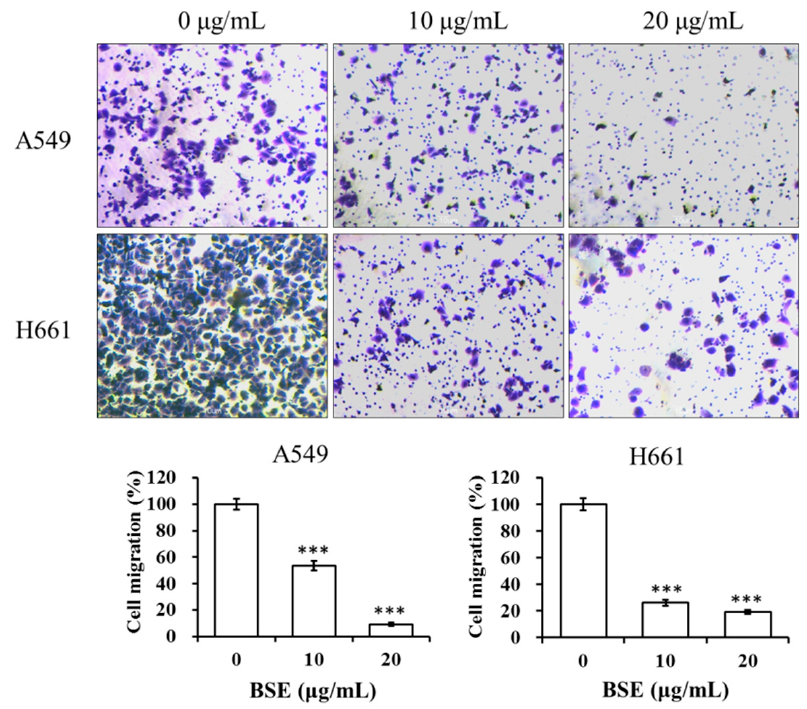
Figure 7. Effect of BSE on A549 and H661 cell migration by transwell assay. An aliquot of 2 × 10 5 cells of A549 and H661, respectively, were seeded onto the upper chamber in serum-free medium with BSE (0, 10 and 20 μ g/mL) for 24 h. The cells migrated through polycarbonate membrane were stained with crystal violet and photographed. The crystal violet-stained cells were calculated. A significant difference from the vehicle was indicated as *** p < 0.001 (Student’s t -test). The inhibitory effects of BSE on the invasion of lung cancer cells were examined by a cell invasion assay with the Boyden chamber coated with collagen. The number of A549 and H661 cells that invaded through the Matrigel was significantly inhibited by BSE treatment (Figure 8).